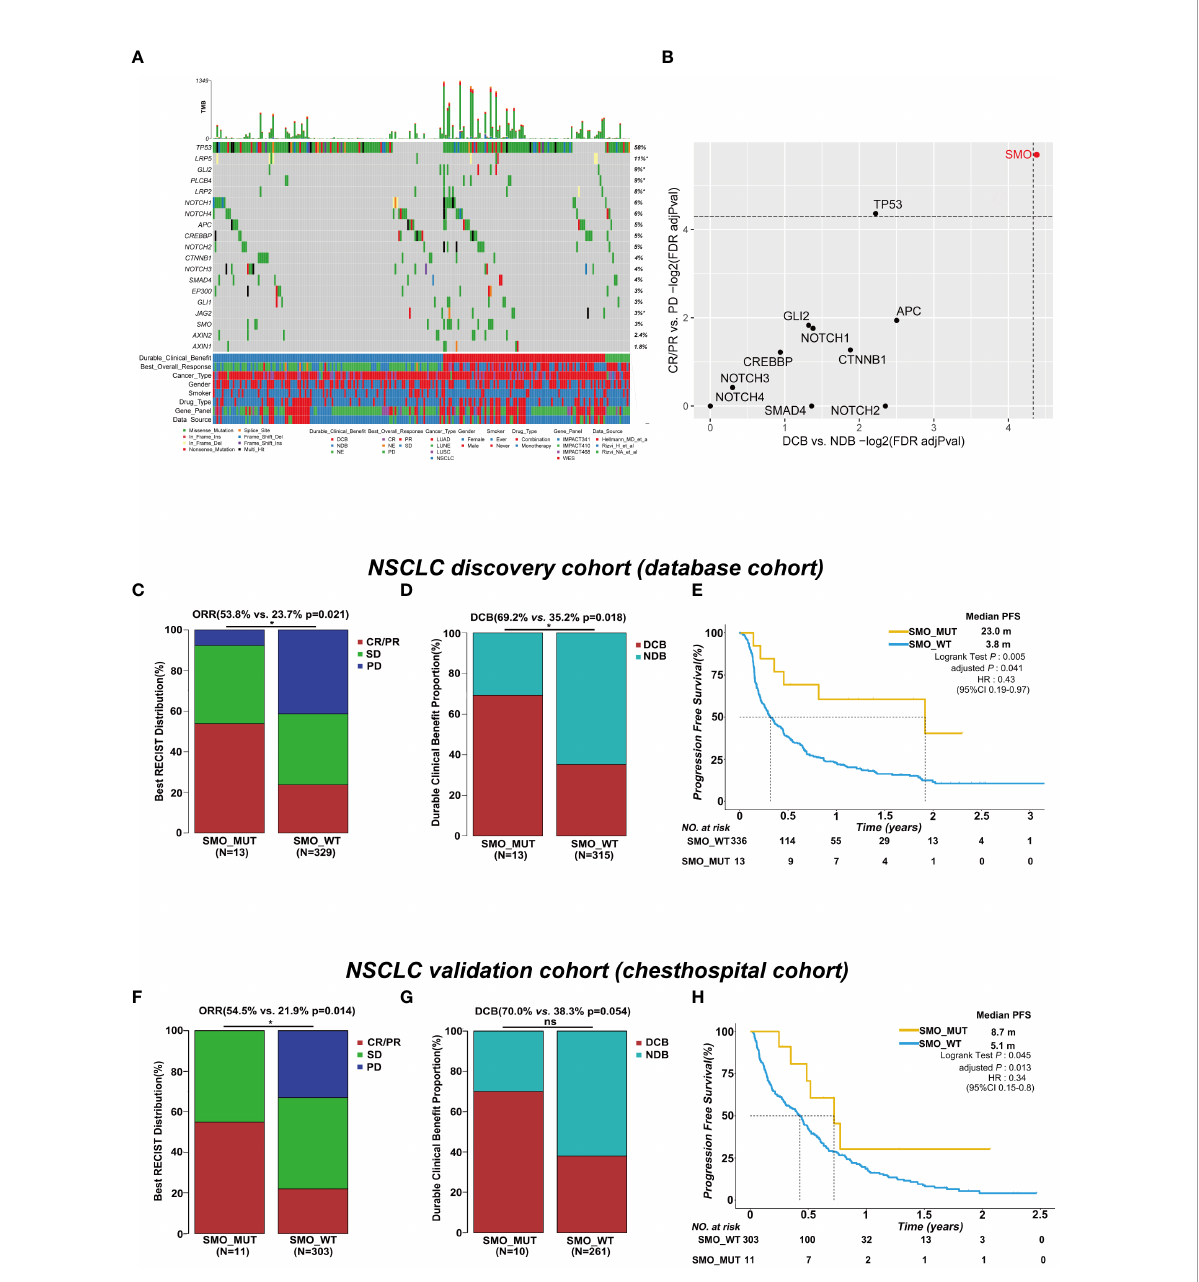
FIGURE 1 SMO mutation predicted favorable clinical outcomes for immune checkpoint inhibitors (ICIs) in the non-small cell lung cancer (NSCLC) cohort. (A) Summary of the mutational and clinical information of patients with NSCLC in the discovery cohort. Individual patients are represented in each column . Categories of durable_clinical_bene fi t (DCB), best_overall_response (BOR), cancer_type, gender, smoker, drug_type, gene_panel, and data_source are characterized. The occurrences of the selected genes in each case are represented in the OncoPrint, with the percent frequency shown. Asterisk denotes genes that were not covered in the MSK-IMPACT (Integrated Mutation Pro fi ling of Actionable Cancer Targets) panel. (B) Associations between mutations in the developmental signaling pathway-related genes and clinical responses [complete response (CR)/partial response (PR) and DCB]. Both dashed lines indicate adjusted p = 0.05 regarding DCB and CR/PR (two-tailed Fisher ’ s exact test). (C, D) Histogram depicting the proportions of objective response rate (ORR) and DCB in SMO mutant (SMO_MUT) and SMO wild-type (SMO_WT) patients in the NSCLC discovery cohort (two-tailed Fisher ’ s exact test). (E) Kaplan – Meier survival analysis comparing the progression- free survival (PFS) between SMO_MUT and SMO_WT patients in the NSCLC discovery cohort (log-rank test). (F, G) Histogram depicting the proportions of ORR and DCB in SMO_MUT and SMO_WT patients in the NSCLC validation cohort (two-tailed Fisher ’ s exact test). (H) Kaplan – Meier survival analysis comparing the PFS between SMO_MUT and SMO_WT patients in the NSCLC validation cohort (log-rank test). * p < 0.05. ns, no signi fi